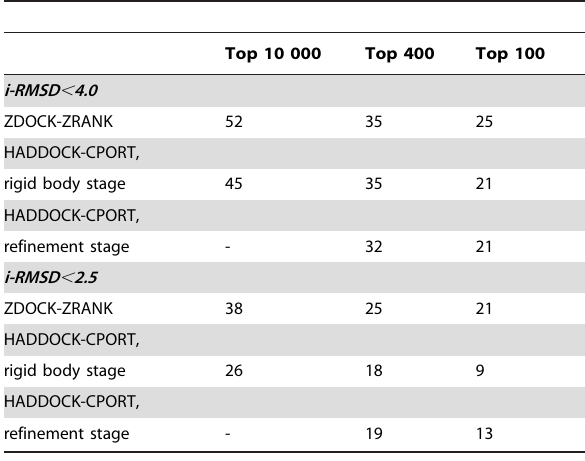
Table 4. Comparison between HADDOCK-CPORT and